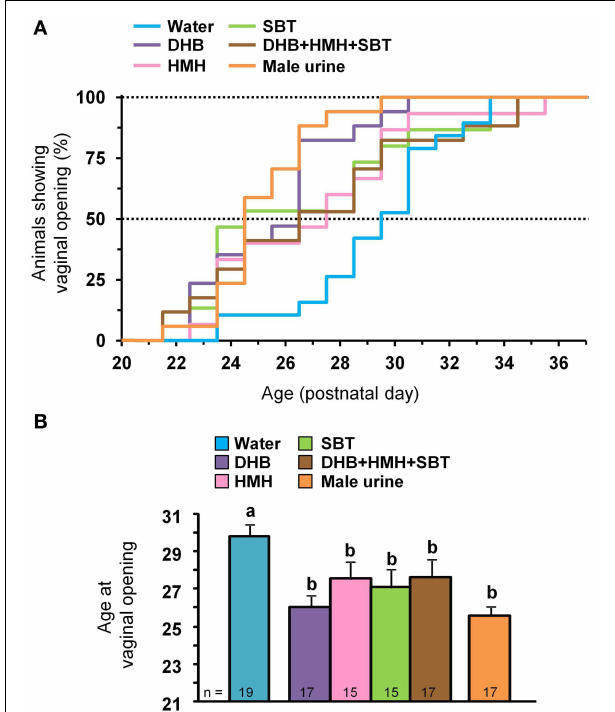
FIGURE 2 | Vaginal opening during exposure to male chemosignals. (A) Cumulative percentage of female Swiss mice showing vaginal opening according to age and exposure to water, DHB, HMH, SBT, a mixture of DHB+HMH+SBT or male urine. (B) Mean age ( ± SE) at vaginal opening according to odor exposure. Dissimilar letters indicate significant differences, p < 0 . 05 using post-hoc Fisher’s LSD test.